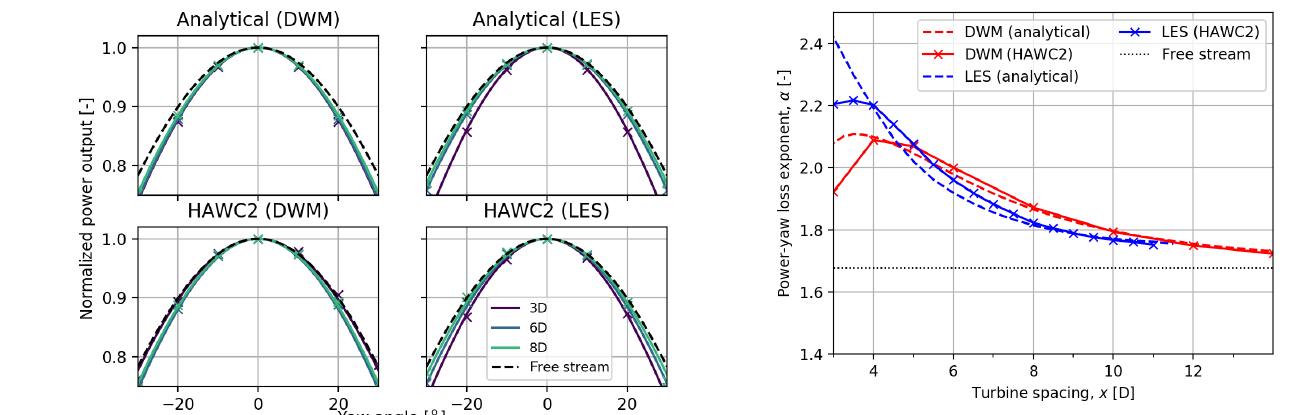
Figure 5. Normalized power output as a function of yaw angle for different turbine spacings. Both calculation methods and wake gen- eration tools are presented. The markers indicate the sample points used in the cosine fitting.